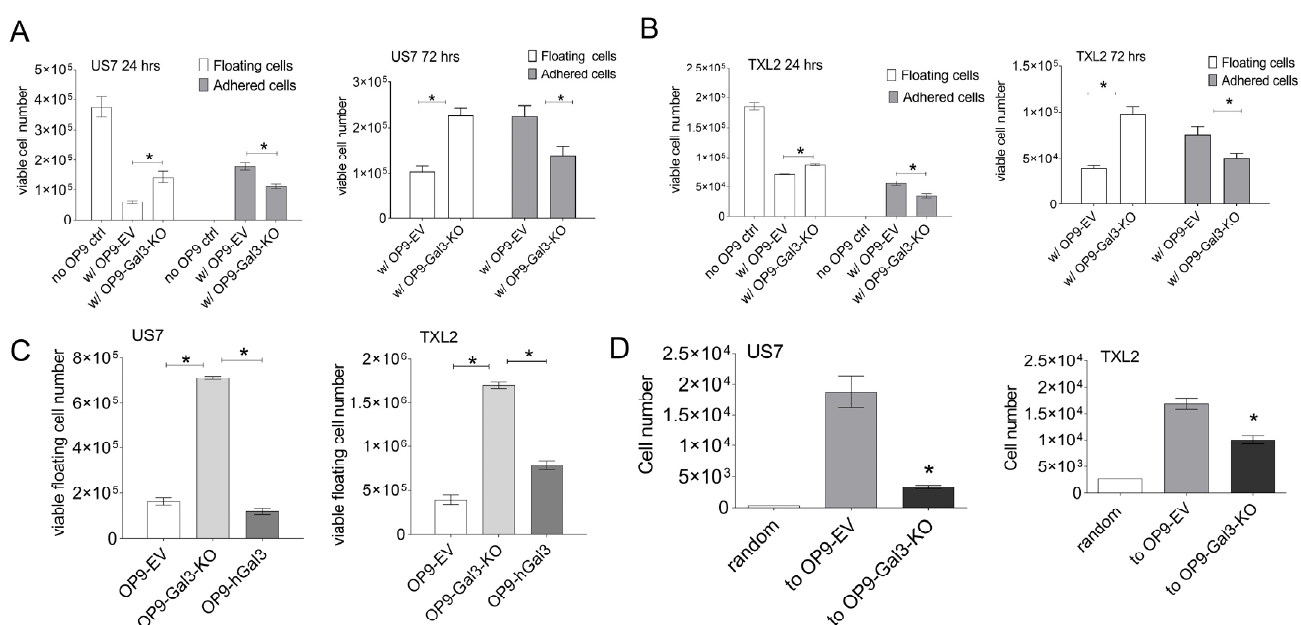
Figure 3. Gal3 deficiency in stromal cells impairs BCP-ALL cell adhesion and migration. Adhesion of BCP-ALL cells to Gal3-deficient OP9 and control stroma presented as number of viable cells. ( A ) US7 cells after 24 and 72 h of migration and adhesion. ( B ) TXL2 cells at 24 and 72 h. ( A , B ) BCP-ALL cells in the supernatant (floating) and attached to OP9 stroma (adhered) were both determined. ( C ) Adhesion of US7 or TXL2 cells to the OP9 cells of the indicated genotype measured after 24 h. OP9-hGal3: OP9 Gal3-KO cells expressing hGal3. ( D ) Migration of US7 or TXL2 cells over a 4 h period toward OP9 Gal3-KO stroma and control OP9-EV cells measured using a Transwell assay. Motility in the presence of medium was used as readout for random (spontaneous) migration. Error bars, mean ± SEM of duplicate values in ( C , D ) or triplicates for ( A , B ) samples. ( A , B ) two-way ANOVA, Šidák’s multiple comparison test; ( C , D ) one-way ANOVA, Tukey’s multiple comparison test. Adjusted p -values. * p < 0.05.